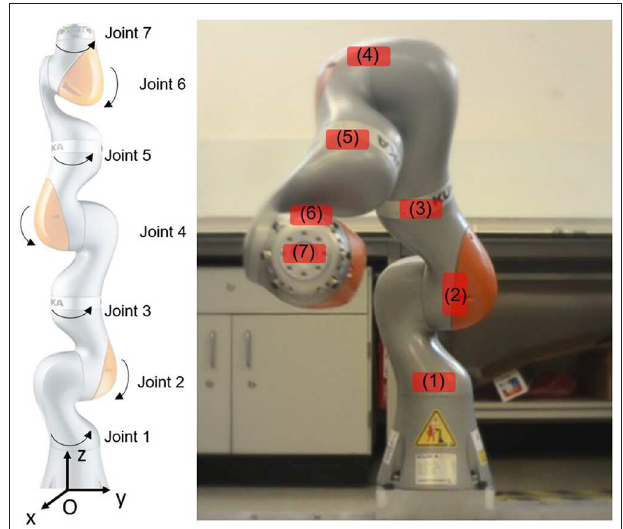
FIGURE 1 | The KUKA iiwa 7 LBR800 robot used in radiation tolerance testing. The left image shows the robot in its “zero” position status, with all the robot joints at their initial zero positions. The positive directions of each joint are indicated. The right-hand photo shows the robot during a mock-up test in which a periodic trajectory was programmed. The red colored areas show mounting locations used for the radiation